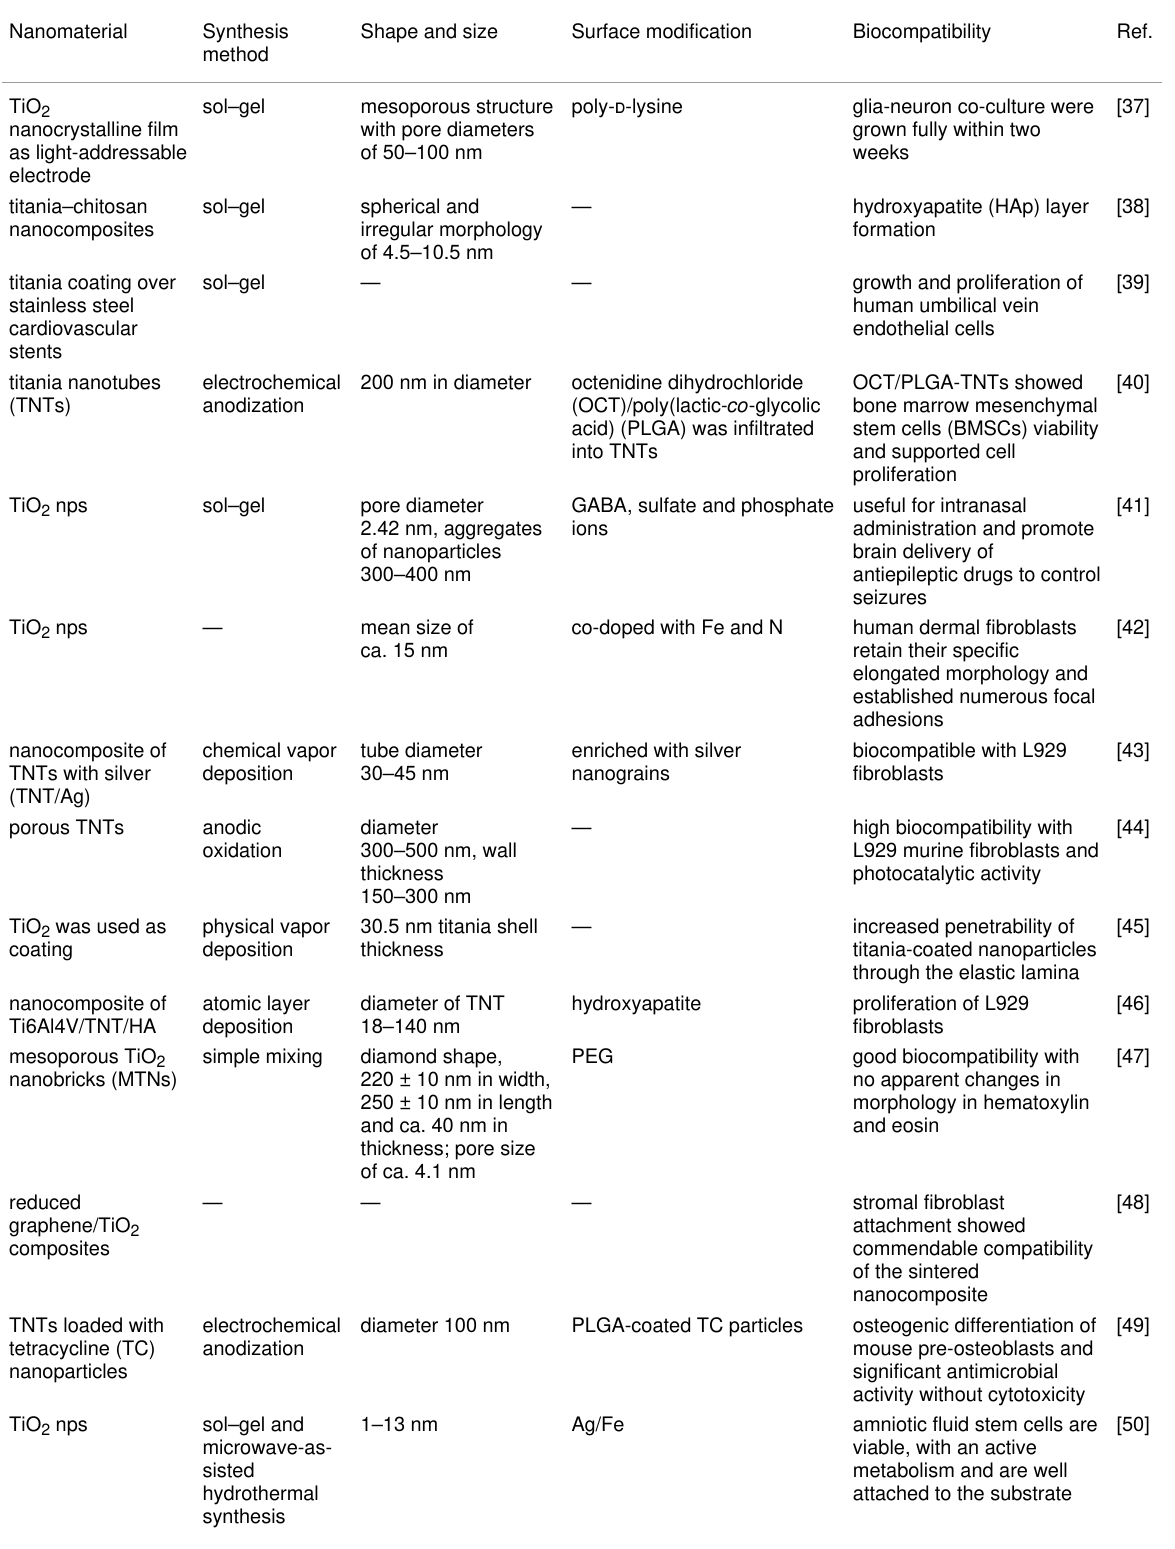
Table 1: Summary of the biocompatible nature of various TiO 2